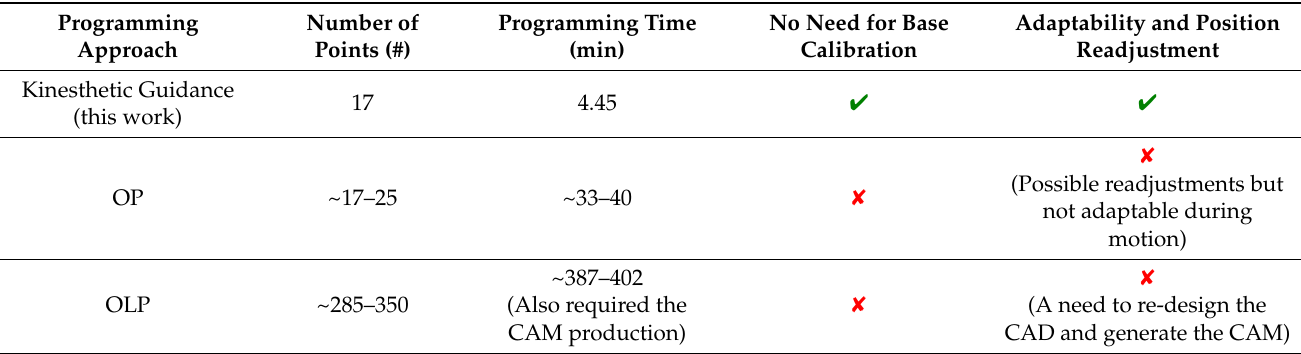
Table 3. Quantitative comparison of the proposed kinesthetic guidance approach for industrial manipulators relative to OP and OLP